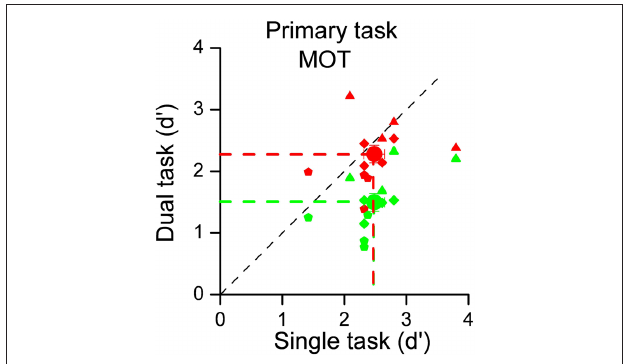
Figure 1 | Sensitivities for the MOT task performed alone (on the abscissa) plotted against sensitivities for dual-task conditions (on the ordinate). The 12 data points represent 4 subjects in 3 experimental conditions, defined by the number of dots to track (from 3 to 5). Green symbols refer to the intra-modal condition (secondary task contrast discrimination), red to the cross-modal condition (auditory secondary task). Small symbols refer to individual data (different symbols shape indicates different number of dots to track: three dots → triangles, four dots → diamond, and five dots → pentagon) whilst large symbols to averages. There is a clear effect for intra-modal interference, but not for cross-modal interference. lie below the equality line. The difference was highly significant